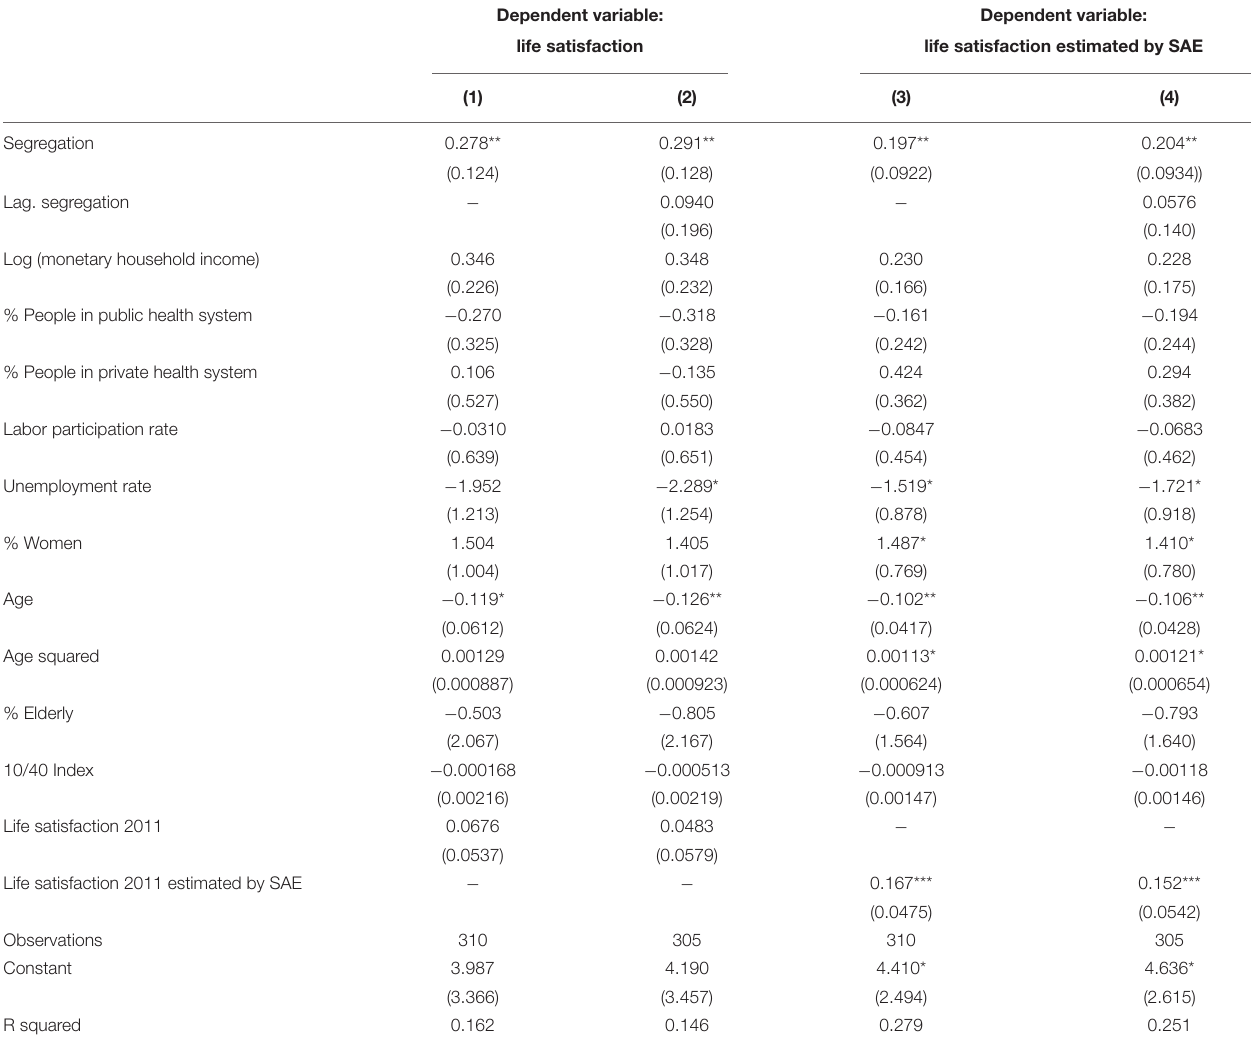
TABLE 6 | Determinants of life satisfaction (evaluating